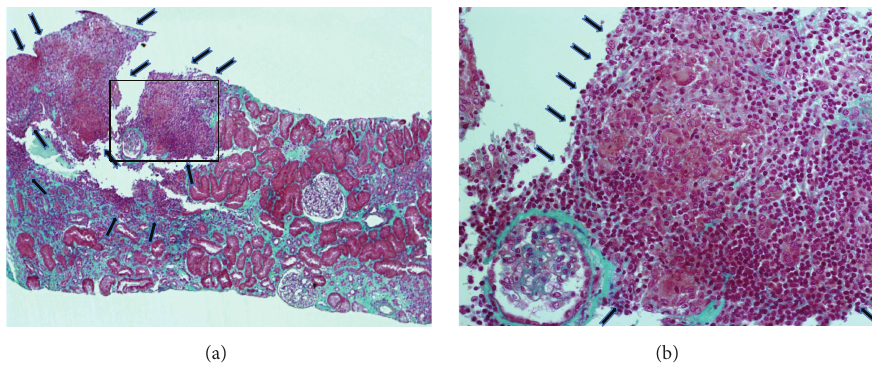
Figure 1: Renal biopsy during AKI. (a) Masson trichrome staining showing nonnecrotic interstitial infiltrate (arrows) affecting 20% of the kidney biopsy (magnification × 40). (b) Higher magnification of the area boxed in (a) showing the granulomatous interstitial infiltrate composed of epithelioid cells (arrow), some multinucleated giant cells (arrowhead), and a lymphoplasmacytic infiltrate (asterisk) (magnification ×